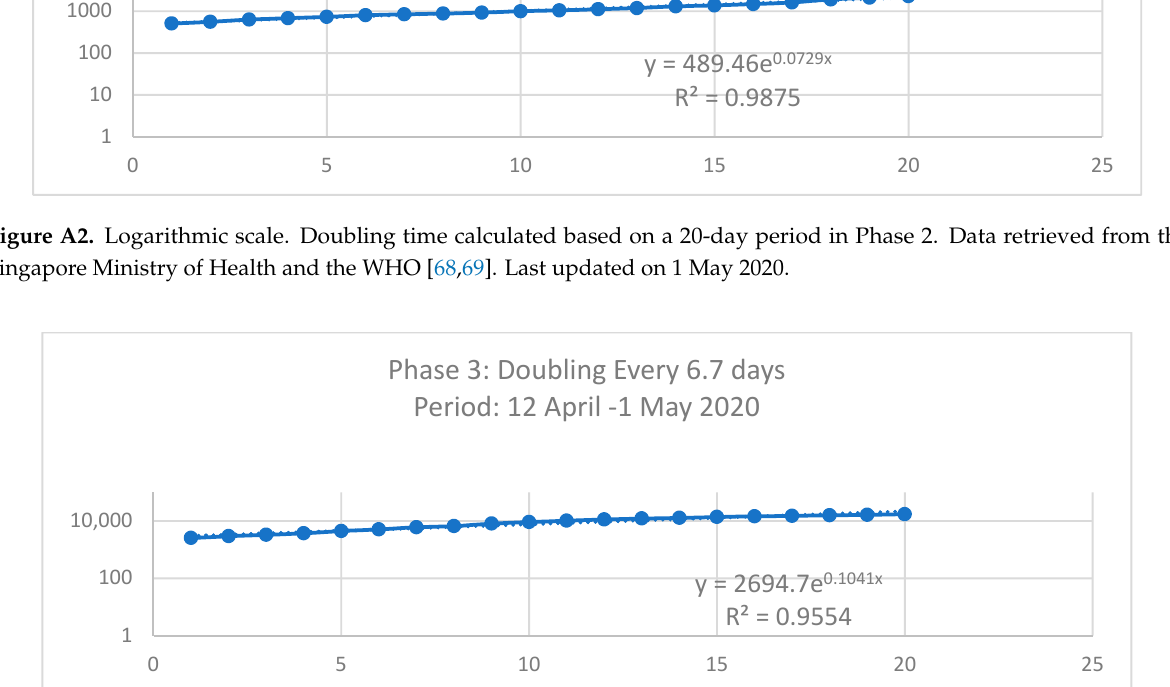
Figure A3. Logarithmic scale. Doubling time calculated based on a 20-day period in Phase 3. Data retrieved from the